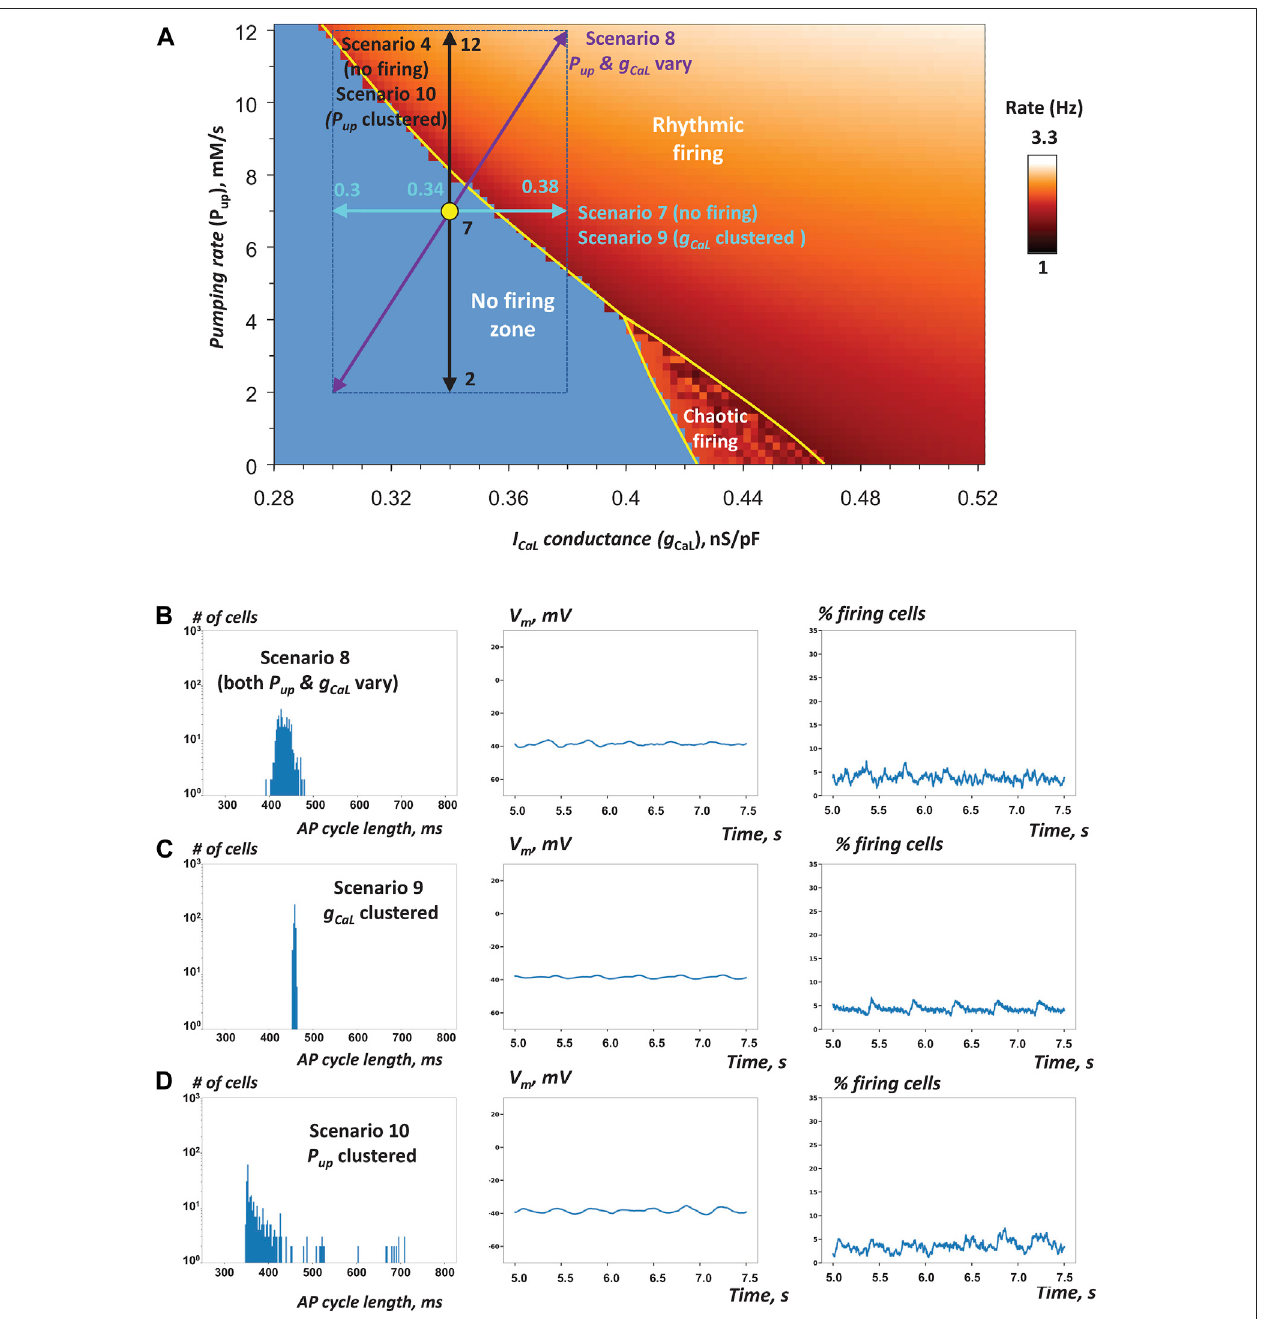
FIGURE 6 | Robustness of SAN operation is increased via combined P up and g CaL heterogeneities and their clustering (A) P up - g CaL bifurcation diagram illustrating cellpopulationsinsimulationsofSANtissuefunctioninscenarios7 – 10( Table1 )similarto Figures3A , 5A .Yellowcircleshowscoordinatesformean P up andmean g CaL values(inthenon- fi ringzone).Double-headedarrowsshow P up and g CaL rangesinthesescenarios.Thetissuemodelswithheterogeneityineithersingleparameterfailed to generate rhythmic APs ( Supplementary Movies S4, 7 ). However, when both parameters fl uctuated, the tissue model fi red rhythmic APs ( Supplementary Movie S8 ). Furthermore, when either parameter ( g CaL or P up ) was clustered, the tissue also generated APs in scenarios 9 or 10 ( Supplementary Movies S9, 10 ), respectively. B – D : the results of simulations in scenarios 8 – 10.